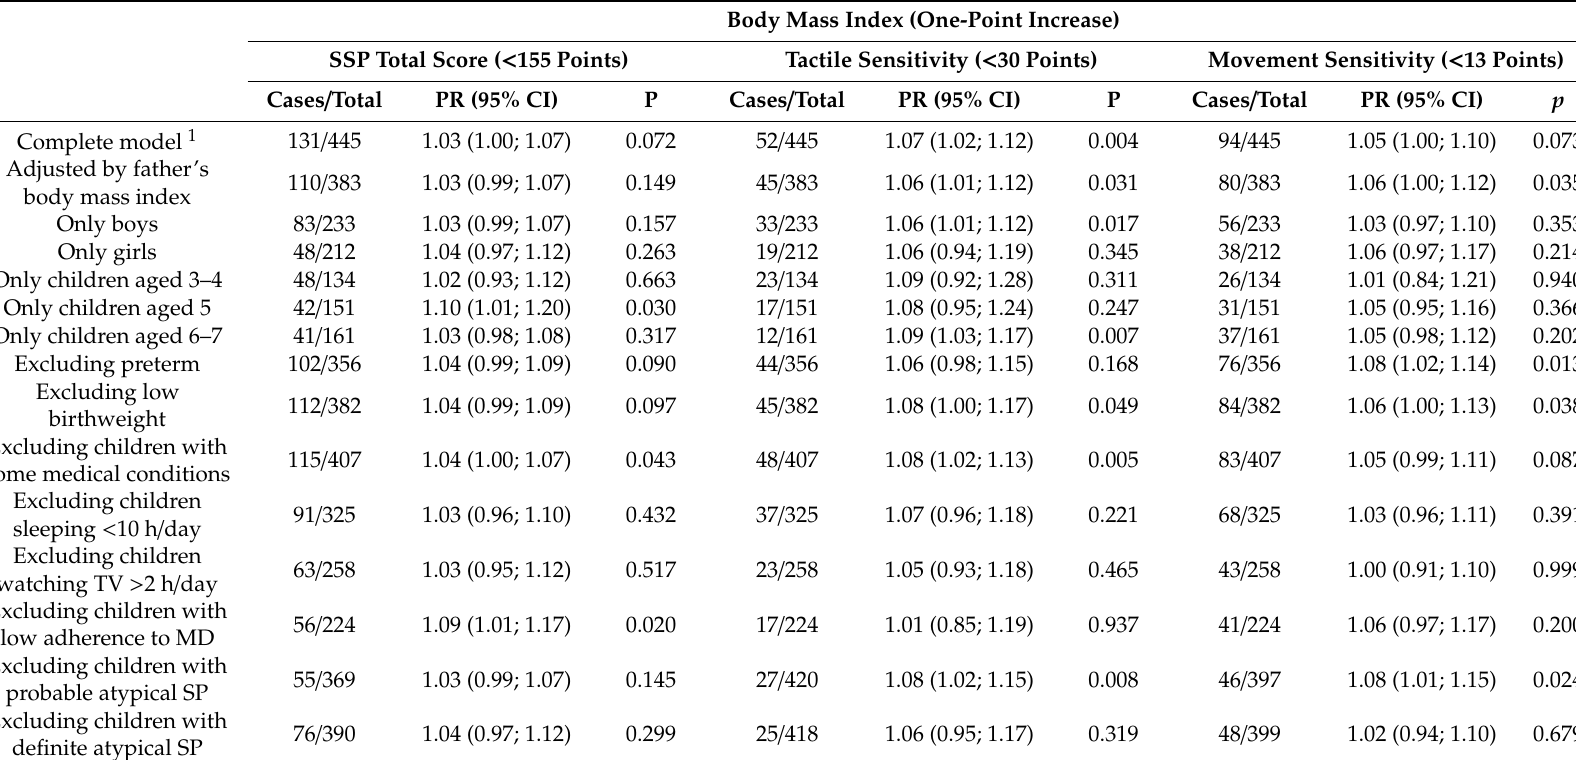
Table 3. Sensitivity analysis of the association between the body mass index (in categories and continuously) and the prevalence of atypical tactile sensitivity as measured by the SSP in children aged 3 to 7 years from InProS Project, Alicante, Spain ( n =